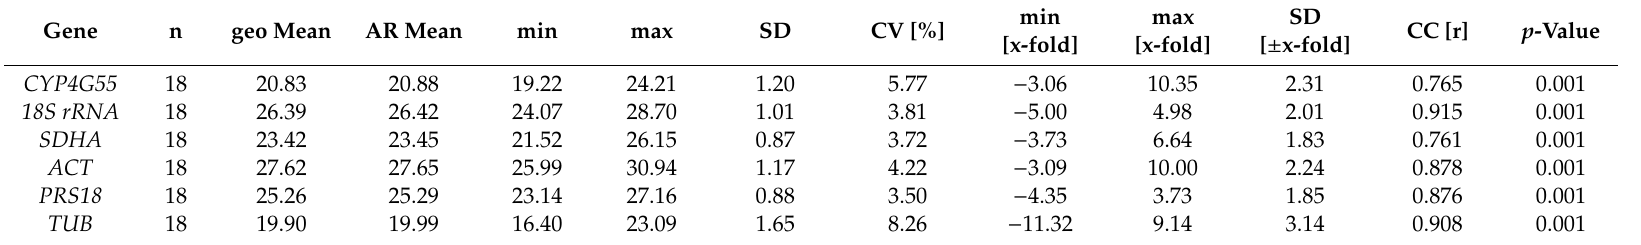
Table 2. Expression stability of the candidate reference genes in adult D. valens evaluated using BestKeeper.